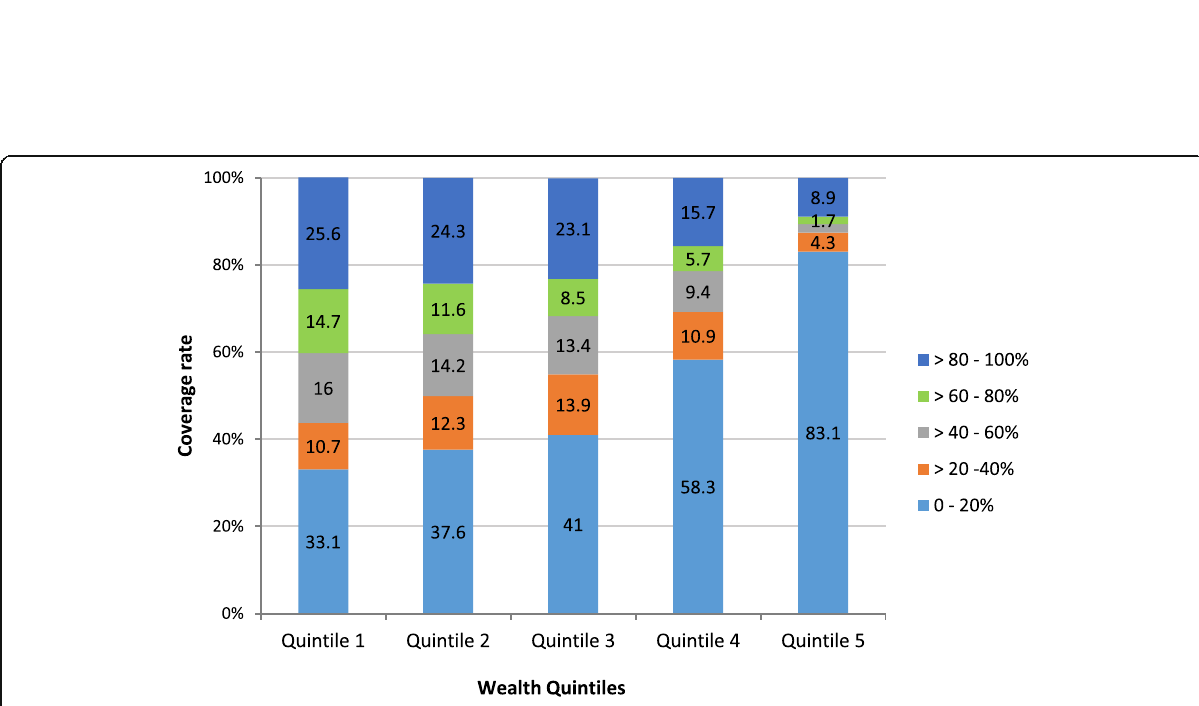
Fig. 2 Numbers and percentages of clusters categorized by the raw coverage rates of unimproved water by quintile. The percentage of clusters with a high number of unimproved water coverage (80-100%) declined from the poorest to the richest quintile, while clusters with 0-20% coverage rise in the same